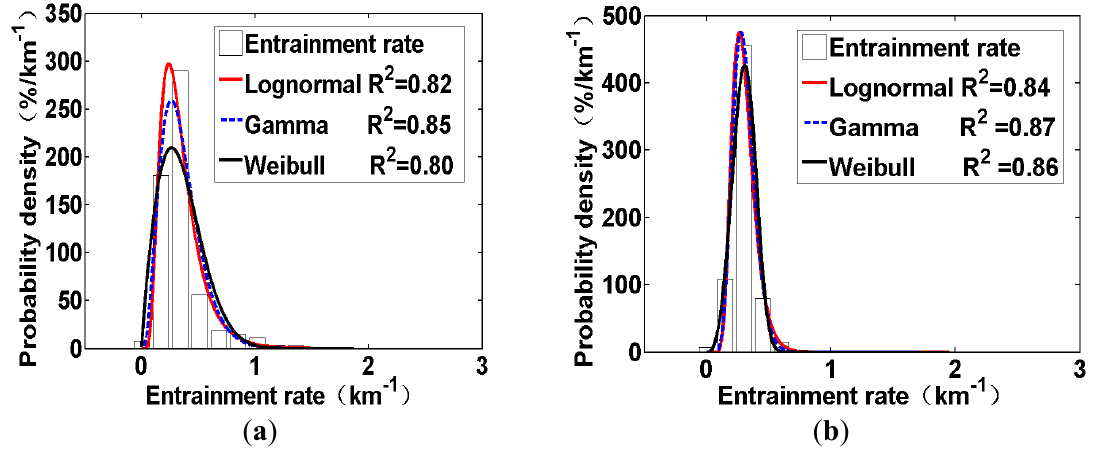
Figure 3. Probability density functions (PDFs) of entrainment rate with the properties of entrained air from the aircraft vertical sounding for ( a ) all 156 clouds, and ( b ) 92 clouds the observational heights of which are around 3000m. The coefficients of determination (R 2 ) for the lognormal, gamma and Weibull fits are also given.